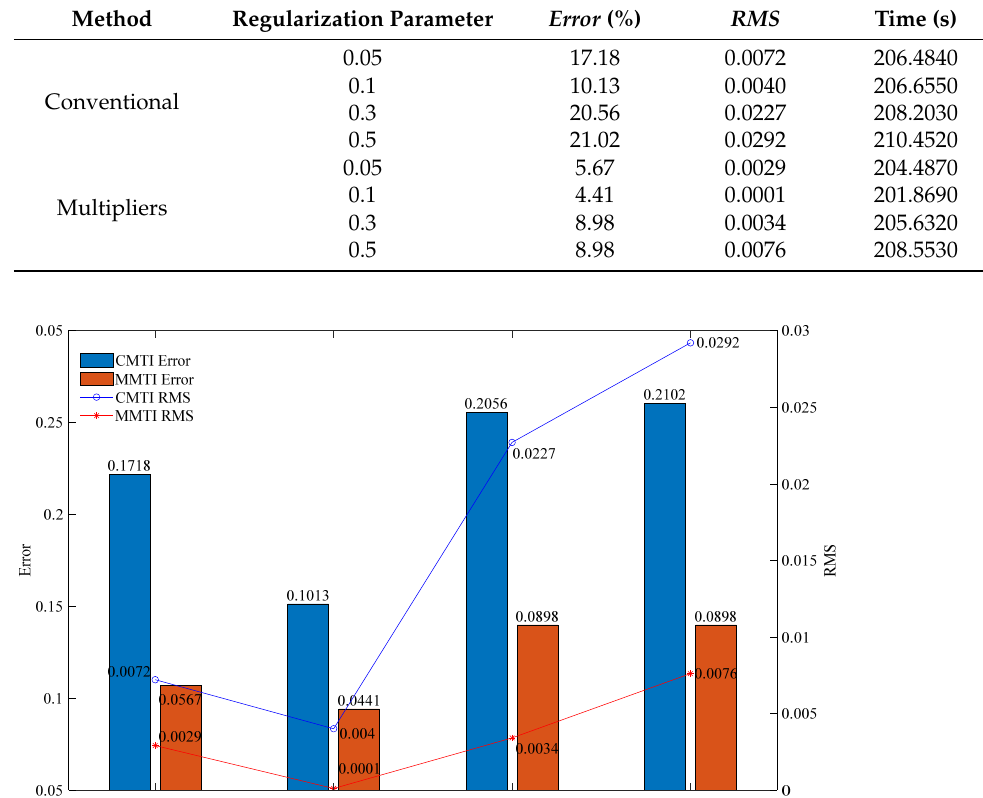
Table 2. Model errors, RMS data fitting error, and inversion times for different regularization factors of the wedge model.